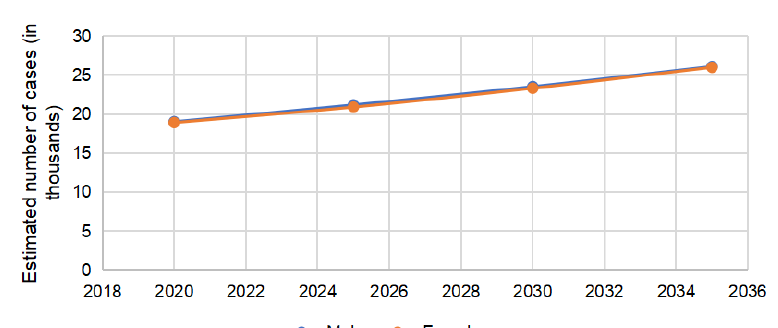
Figure 5. Predicted mortality trends of rectal carcinoma in males and females